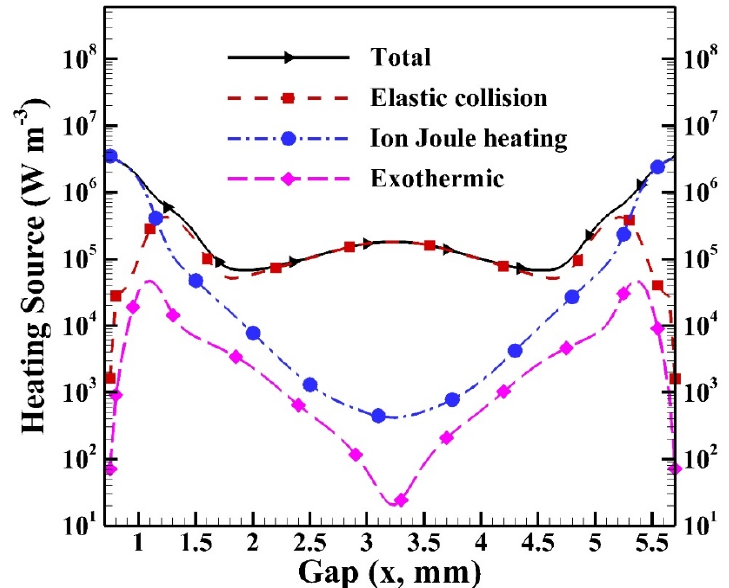
Figure 14. The cyclic average distributions of electron, dominant ion N 4+ , and electron temperature (Te) in the gap.